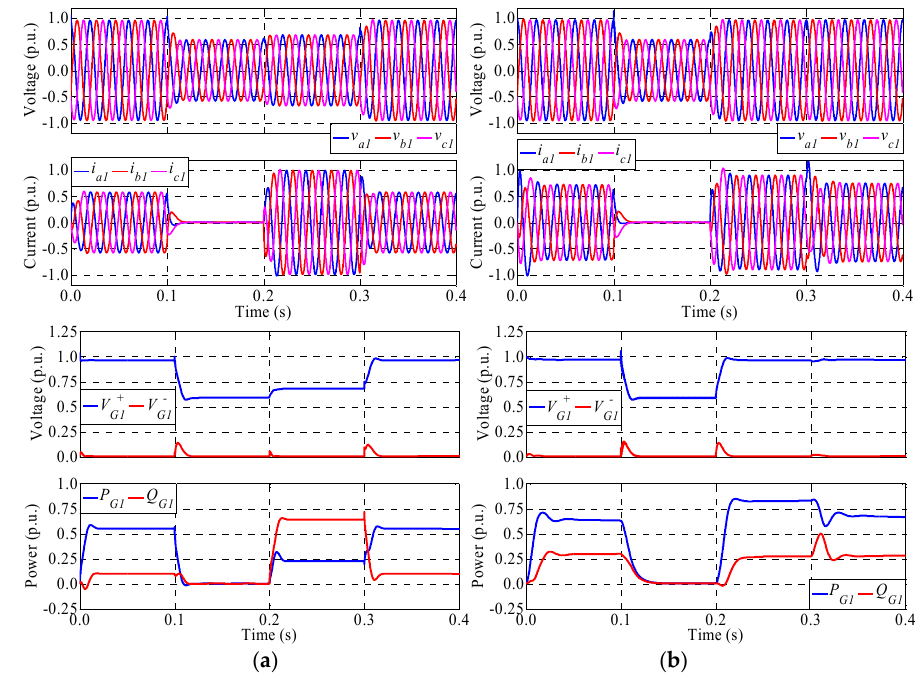
Figure 12. Main waveforms of generator 1 using the ( a ) GCCS1 and ( b ) IVS control schemes for type III voltage sag.